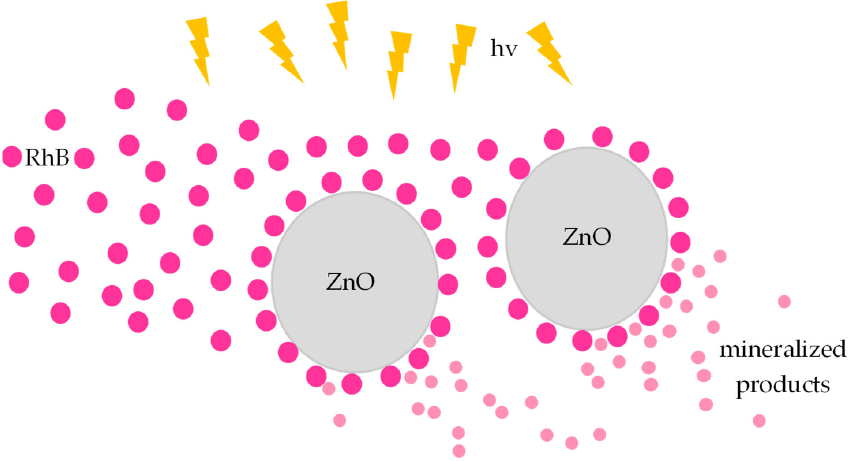
Figure 16. The main steps of the heterogeneous photocatalytic degradation of RhB by ZnO.